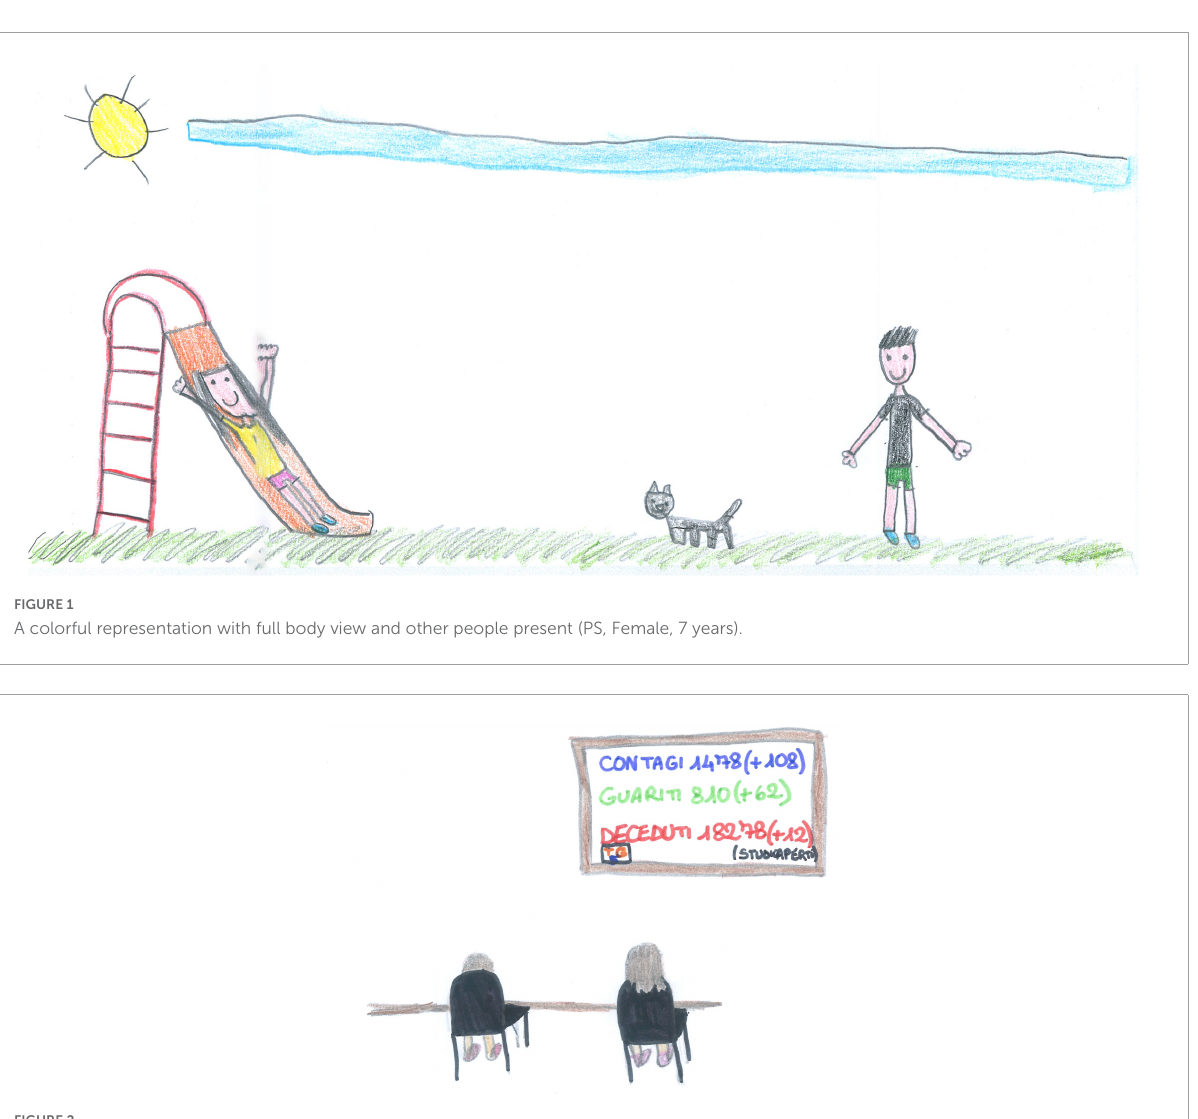
FIGURE2 An example of back view representation. The screen is reporting on the increase of the contagions, recovered people and death (SS, Female, 11